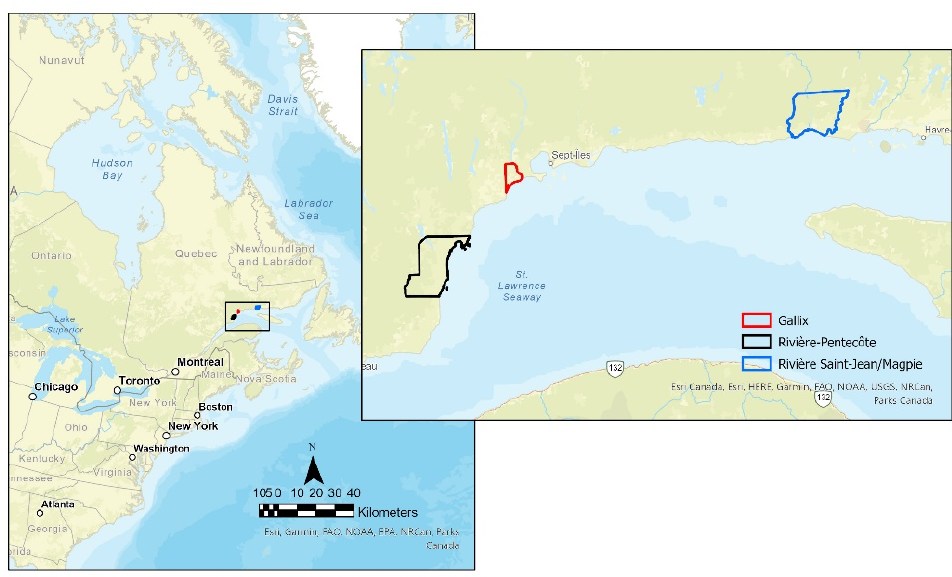
Figure 1. Localization of the communities.